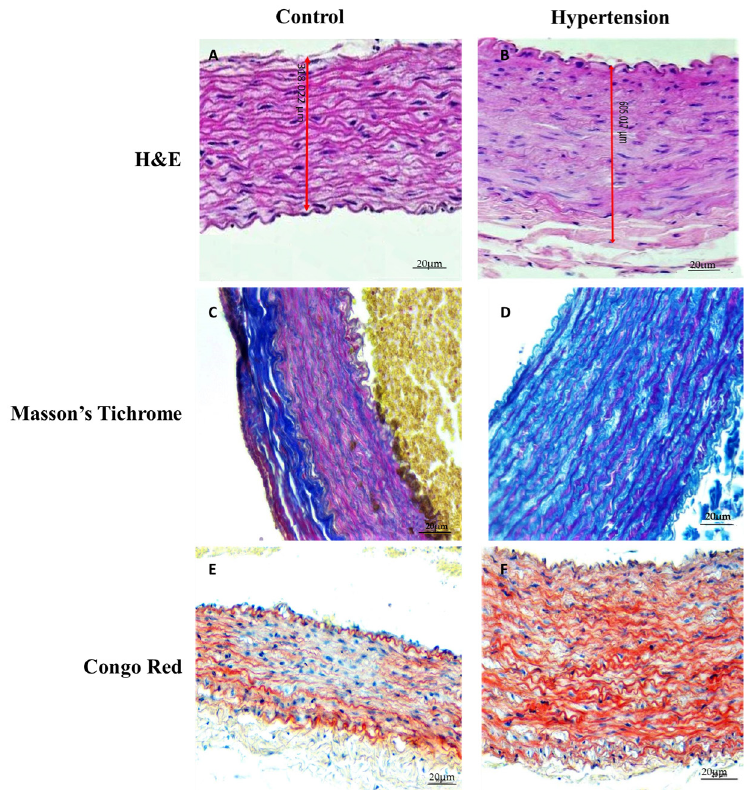
Figure 2. Histological stains of the aortic intima-media layers in samples collected from the control (first column) and the hypertensive group (second column). ( A ) H&E-stained section of the control group showing the thickness of the control sample and the circumferential tendency of the SMCs (in a “stretched” state) across the media. ( B ) H&E-stained section of the hypertensive group showing severe thickening of the media. Most SMCs have lost their circumferential tendency, appearing as round spots across the wall, in the hypertensive group. ( C ) Intact elastic sheets with adjacent collagen content and SMCs are evident on Masson’s trichrome stain of the control group. ( D ) Elastic sheet integrity is disrupted, and collagen fibers are substituted in these regions. Additionally, the SMC content of the wall markedly declined in the hypertensive group. ( E ) Congo red stain of the control group indicated no amyloid deposition. ( F ) Focal depositions of amyloid are noticed across the wall for the hypertensive group. Bar: 20 μ m.